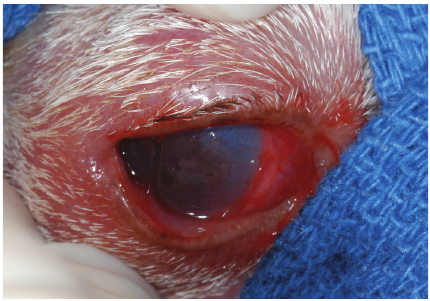
Figure 1: Appearance of right eye on initial presentation. Notice fluctuant swelling of the conjunctiva. There is also mild corneal edema and neovascularization.